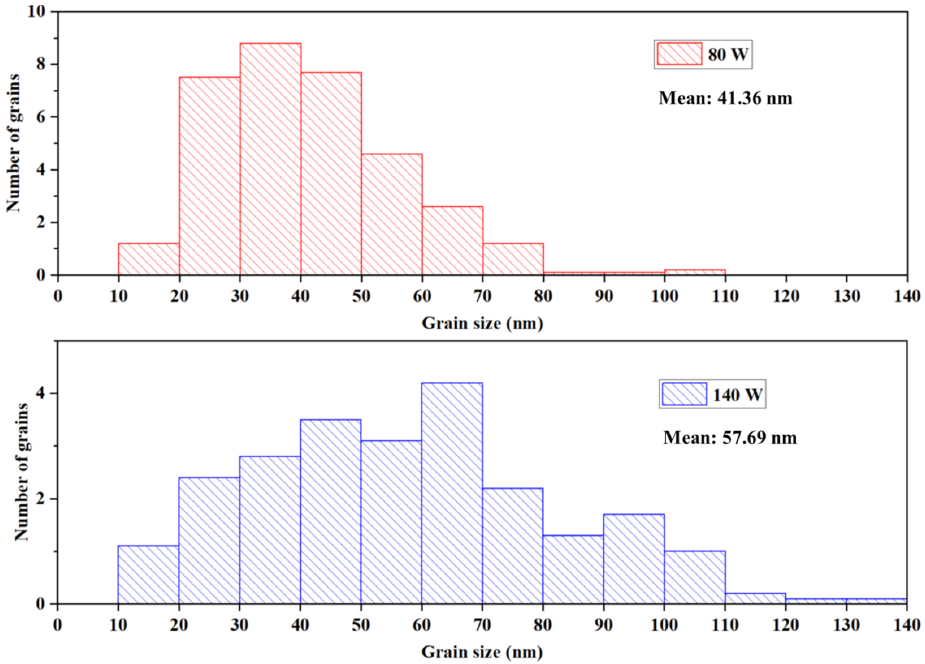
Figure 4. Distribution of grain sizes in Mo ‐ 80 and Mo ‐ 140 samples.